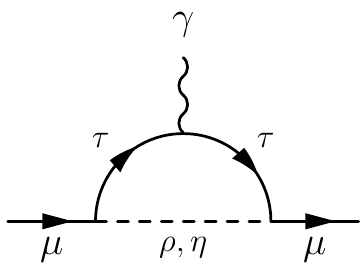
Figure 2 . Feynman diagram inducing muon anomalous magnetic moment in Z 4